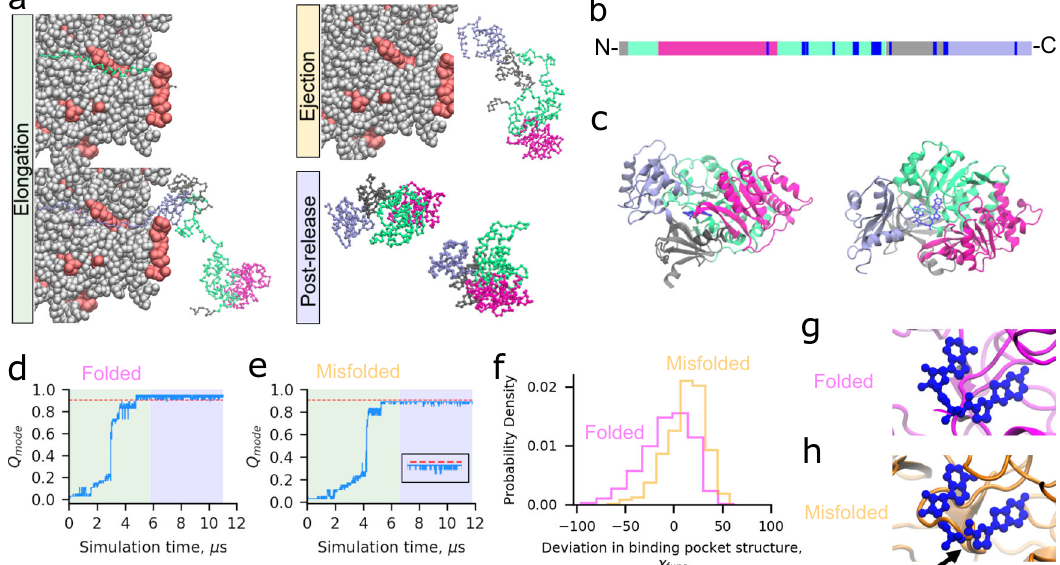
Fig. 1 Luciferase exhibits subpopulations that misfold into soluble but less-functional conformations. a Simulations of translation elongation and ejection of nascent Luciferase were performed with a coarse-grain ribosome representation (ribosomal proteins and RNA are displayed in red and gray, respectively). Domains 1, 2, 3, and 4 of Luciferase are displayed in silver, light green, magenta, and light purple, respectively. After ejection, the ribosome is removed and post-release dynamics simulated for 30 CPU days. b Primary structure diagram of Luciferase colored as described in ( a ); positions involved in the catalytic function of Luciferase as described in “ Methods ” are colored blue. c Cartoon diagram of Luciferase native state colored as described in ( a ) with the 5 ′ -O-[N-(dehydroluciferyl)-sulfamoyl]-adenosine ligand colored dark blue. d Q mode (see “ Methods ” ) versus time for Domain 2 of a trajectory of Luciferase that folded correctly. Plot sections colored green, yellow, and blue correspond to synthesis, ejection, and post-translation simulation phases. (cid:4) Note that the short duration of ejection for this protein renders it invisible at this resolution. The red line corresponds to Q NS mode deviations and represents the threshold for de fi ning this domain as folded (see “ Methods ” ). e Same as ( d ) but for a trajectory that misfolds. Inset shows the fi nal microsecond of the Q mode time series. f Distributions of χ (Eq. (13)) over the fi nal 100 ns of the folded (magenta) and misfolded (orange) func trajectories displayed in panels ( d ) and ( e ). The misfolded and folded distributions are different based on the Kolmogorov – Smirnov test with test statistic 0.33 and p -value of 1 × 10 − 66 . The misfolded distribution shows greater structural distortion (i.e., values of χ > 0) of the binding pocket. g Back-mapped func all-atom structure from the fi nal frame of the folded simulation shown in ( d ) aligned based on the residues implicated in function to the native state. h Same as ( g ) except for the fi nal structure from the misfolded trajectory in ( e ), showing a strand misfolding in the ligand-binding pocket (indicated by black arrow). Steric con fl ict between where the substrate binds and the surrounding binding pocket of the misfolded structures indicates this misfolded state will have reduced